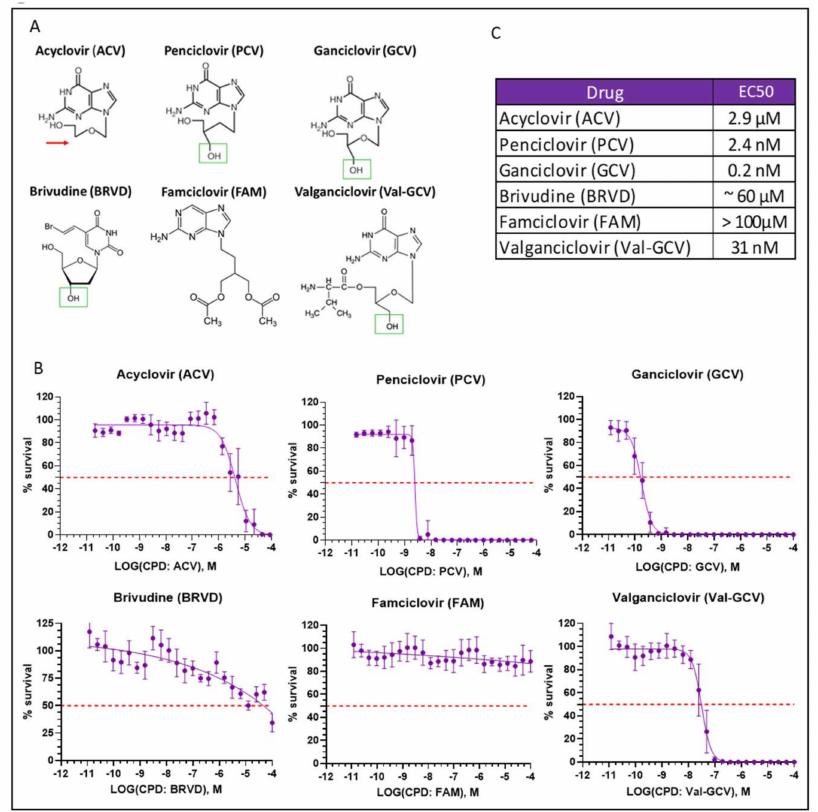
Figure 5. Cell death induction by antiviral nucleoside analogs in SR39h-expressing hESC. ( A ) Chem- ical structures of the antiviral nucleosides acyclovir (ACV), penciclovir (PCV), ganciclovir (GCV), brivudine (BVDR), famciclovir (FAM), and valganciclovir (Val-GCV). The green boxes highlight 3 (cid:48) -hydroxyl groups (required for chain elongation). ACV does not have a 3 (cid:48) -hydroxyl group (red arrow). ( B ) Nucleoside-induced cell death in SR39h-expressing cells. Cells were exposed to increas- ing concentrations of the respective nucleosides for 96 h and cell viability was assessed using an ATP-based assay. Results are mean + SD of three independent experiments performed in triplicates. The dotted line indicates 50% cell survival. ( C ) Summary table of the respective EC50